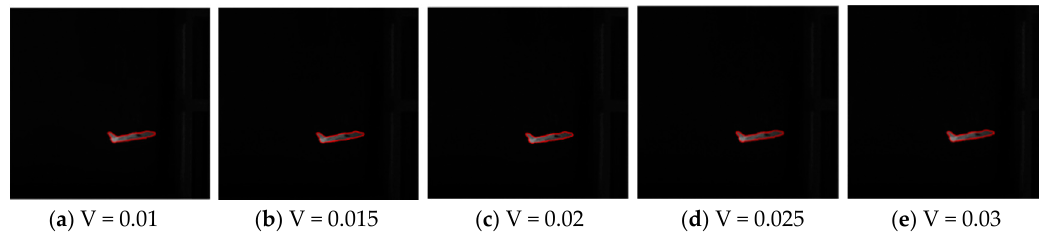
Figure 14. Segmentation results in the infrared images with different ‘V’ values of noise intensity. (The noise intensity gets higher from left to right.)